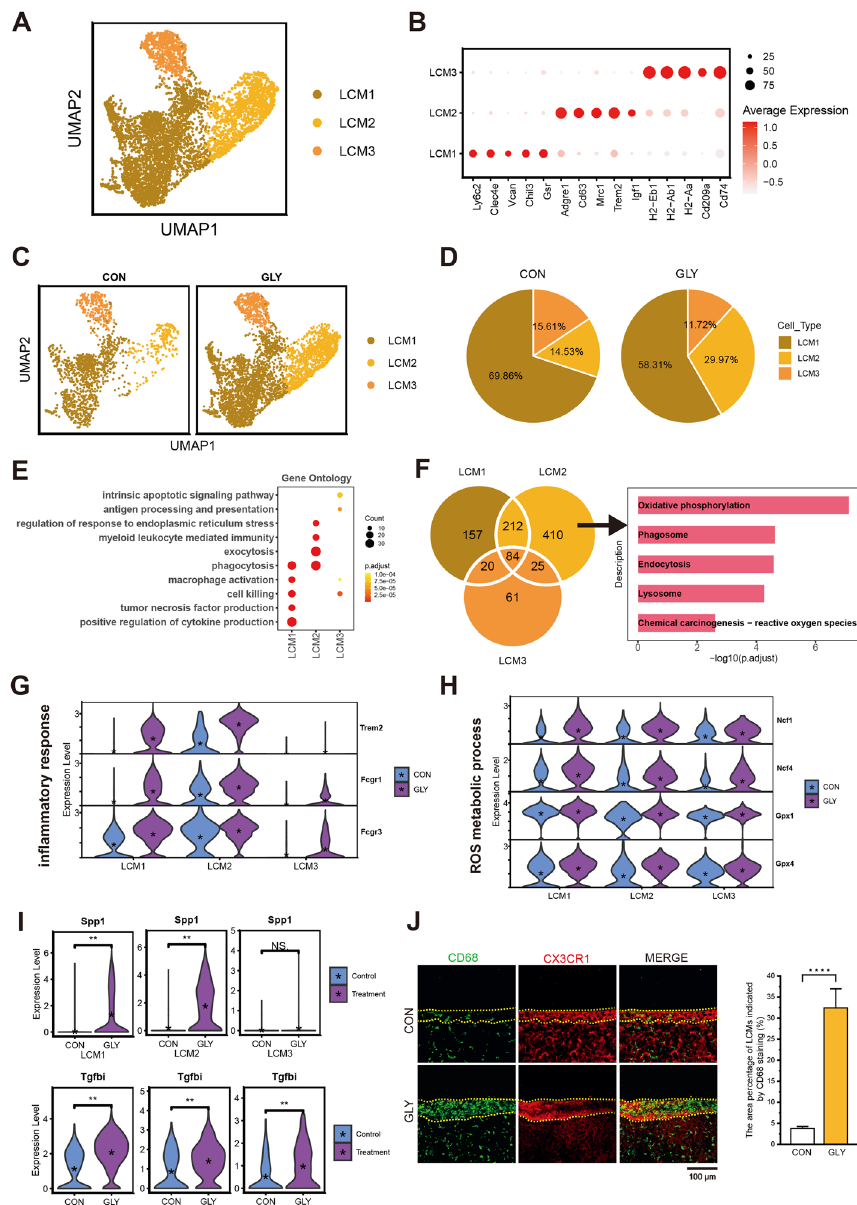
Fig. 5 Inflammatory response and pro-fibrosis of LCMs after GLY treatment. A UMAP visualization of the three subtypes for LCMs. B The expression of specific marker genes identified the subtypes of LCM. C The distribution of each cell type in control and GLY groups. D Pie plots showing proportional changes of each cell type for two groups. E GO analysis for upregulated DEGs of different cell subtypes. F Venn diagram displaying the numbers of upregulated DEGs in the three subtypes (left). GO analysis for unique upregulated DEGs of LCM2 after GLY treatment (right). G Violin plots showing the expression levels of inflammatory response-related genes in each subtype. H Violin plots showing the expression levels of ROS metabolic process-related genes in each subtype. I Violin plots showing the expression levels of Spp1 and Tgfbi genes in each subtype. P value is from wilcox.test (unpaired and two-tailed); ** P < 0.001; NS, not significant. J Typical images and bar graph showing the increased area percentage of CD68 in the liver capsule after GLY treatment. The liver capsule outlined by yellow-dotted lines was denoted by Cx3cr1 staining; scale bar, 100 μm; error bar, mean SD; P value is from Student’s t -test (unpaired and two-tailed); **** P 0.0001; the ± ≤ quantification was based on eight random areas from each